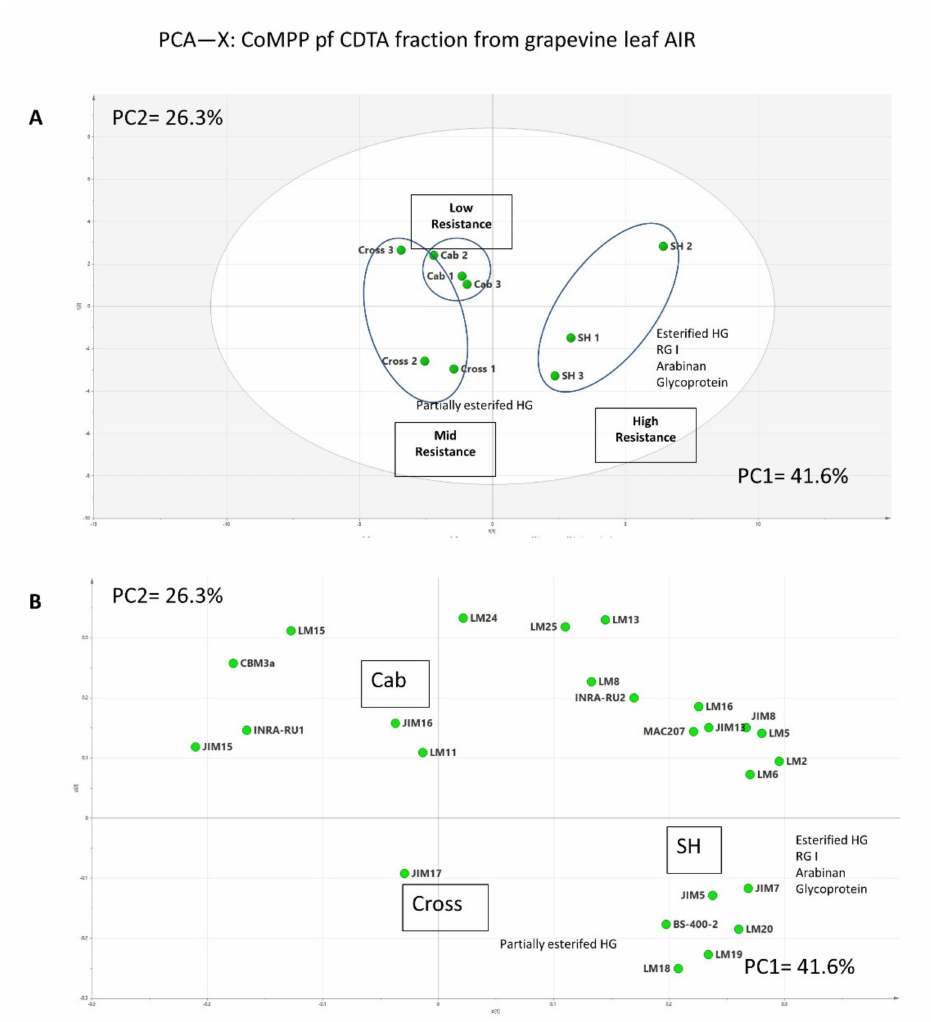
Figure 3. PCA score plot ( A ) and loading plot ( B ) of the CDTA (pectin-rich) extract from AIR sourced from grapevine